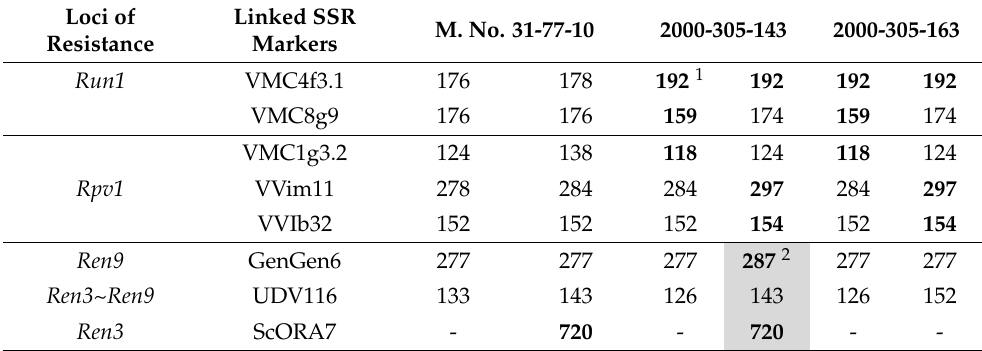
Table 3. Assessment of parental genotypes of hybrid populations with SSR markers associated with loci of resistance to powdery mildew and downy